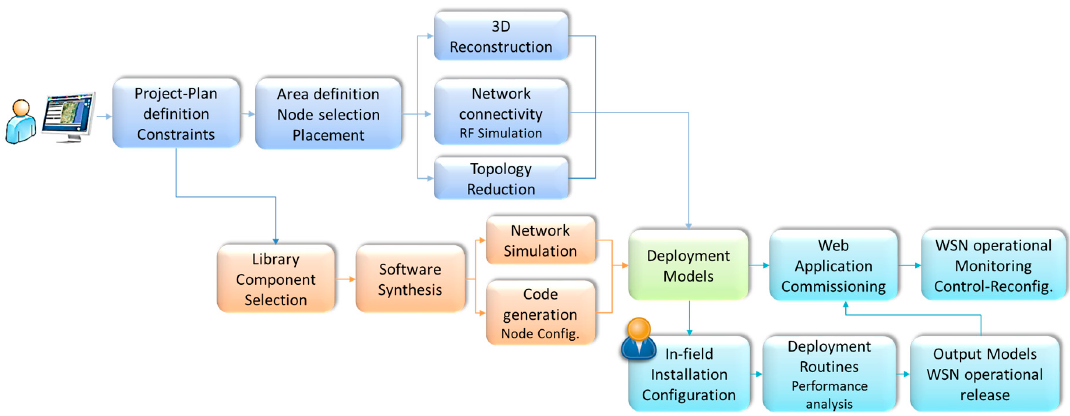
Figure 26. Overall end-to-end flow of the demonstrator implementation by using the DPCM toolset.